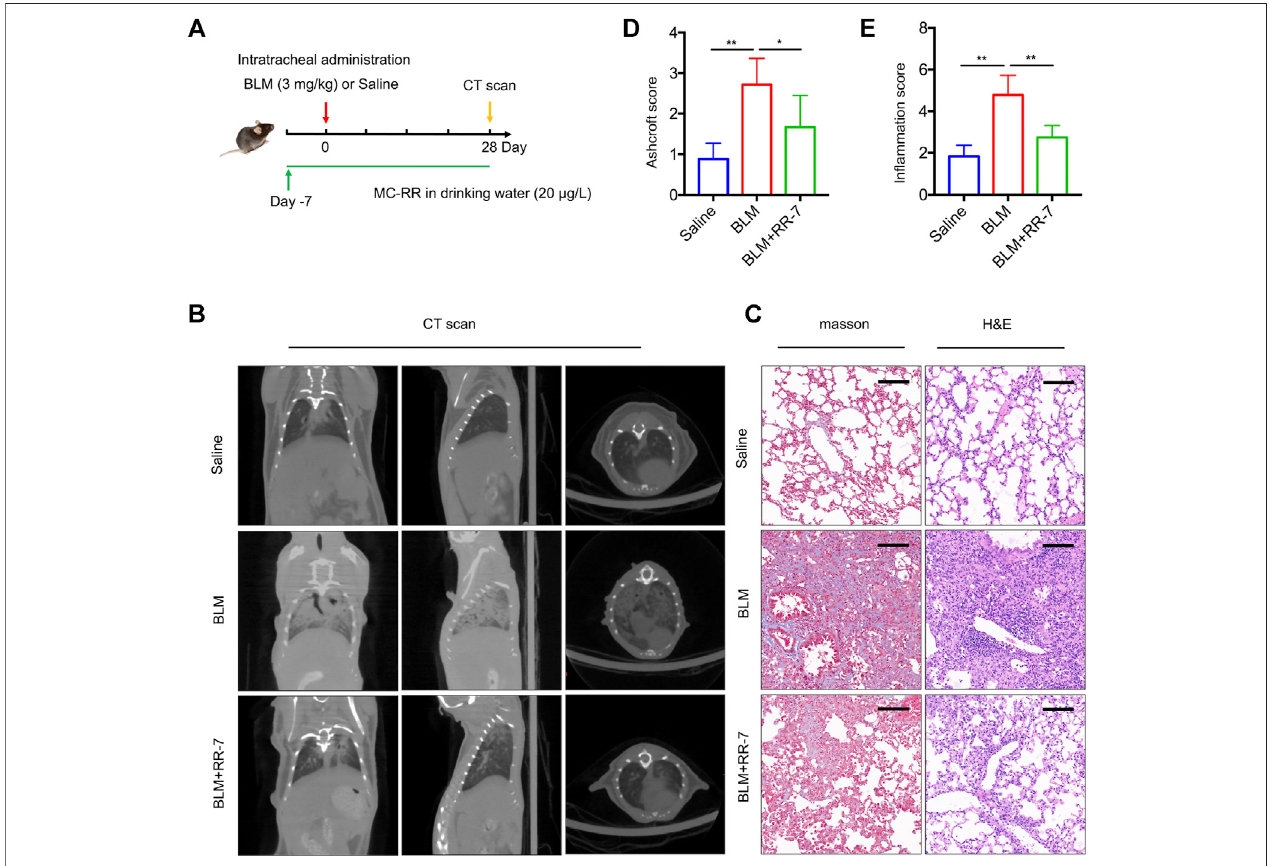
FIGURE2| Microcystin-RR (MC-RR) exerts apreventiveeffectonpulmonary fi brosismodels.Mice weretreatedwithMC-RR (20 μ g/L)indrinking waterfor7 days and subsequently received intratracheal instillation with a single dose of bleomycin (BLM, 3.0 mg/kg), followed by MC-RR administration in drinking water for additional 28 days.TheBLMgroup receiveddistilled waterinsteadofMC-RR.Micethatreceived intratracheal instillationofanequalvolume ofsaline wereusedascontrol.Onday 28 after BLM instillation, all mice were scanned with micro-CT and euthanized for analysis. (A) Schematic representation of the experimental design. (B) The radiologic characteristics of the lungs of mice were determined by Micro-CT. (C) Lung tissue sections were prepared and subjected to Masson ’ s trichrome and H&E staining. Scale bar: 100 μ m. (D,E) Ashcroft and in fl ammation scores of stained sections of lung tissues were measured and are shown as the mean ± SD. Data are expressed as mean ± SD. * p < 0.05, ** p < 0.01 determined by one-way ANOVA with S-N-K post-hoc analysis. Each group had fi ve